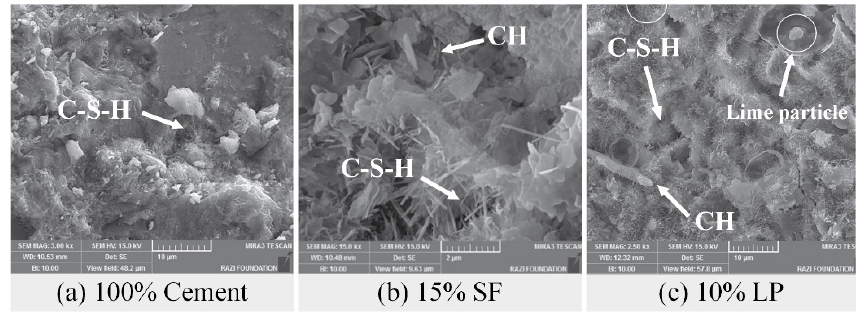
Figure 8. SEM images of SCC mixed with SF and LP [33].